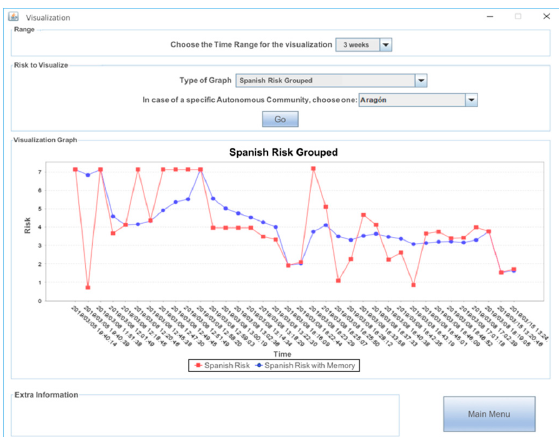
Figure 10. Visualization of the risk history of Spain. The first section allows the analyst to select a temporary viewing window, in this case, 3 weeks of risk history. The second section offers the option of selecting the graph to be displayed; in this case, the grouped risk of Spain. Finally, the lower section shows the visualization of the selected data in the time window defined at the top, differentiating the instantaneous risk (square red), and the risk with memory (blue circle line). As can be observed, the risk with memory tends to follow the trend of the instantaneous, but if the variations are very fast, it tends to represent the average of these. The strongest peaks of memory risk are due to the fact that certain measurements are composed of a large number of threats and, therefore, great representativeness. The history described in Figure 10 is composed of 36 risk measurements, each generated with a range of threat events from 100 to 500. Each threat event has been compounded by its geographic location, IP, a timestamp, severity index, the event confidence, name of the detected threat, etc. The threats simulated were balanced in terms of impact level and confidence in the source of information. This is why the instantaneous trend, represented by the red line, has such pronounced peaks.